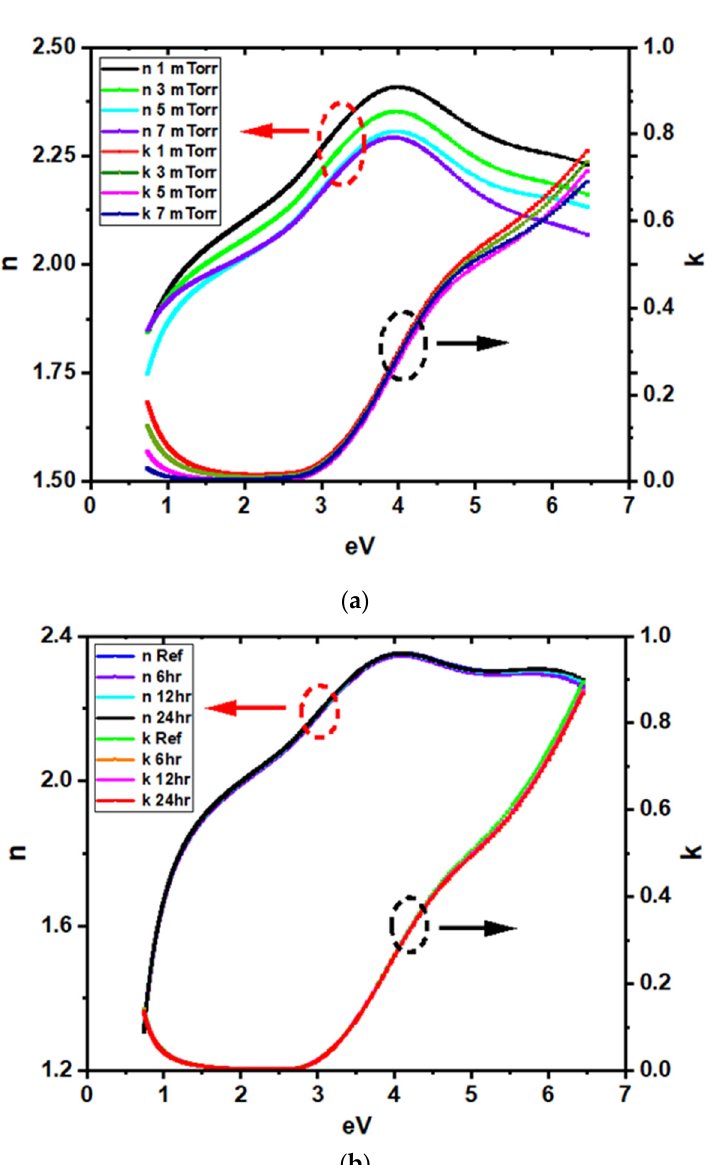
Figure 3. Dielectric functions of ( a ) intrinsic zinc oxide/indium tin oxide (i-ZnO/ITO) deposited at various pressures and ( b ) i-ZnO/ITO deposited at 5mTorr, water-soaked for various durations.